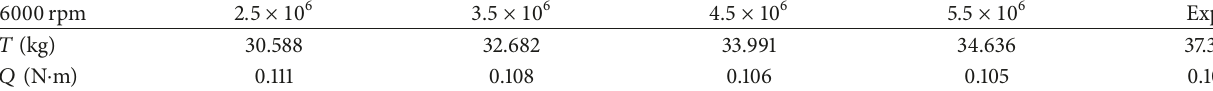
Table 3: Hovering thrust and trimmed torque versus mesh quantity based on MFR model at 6000 rpm.